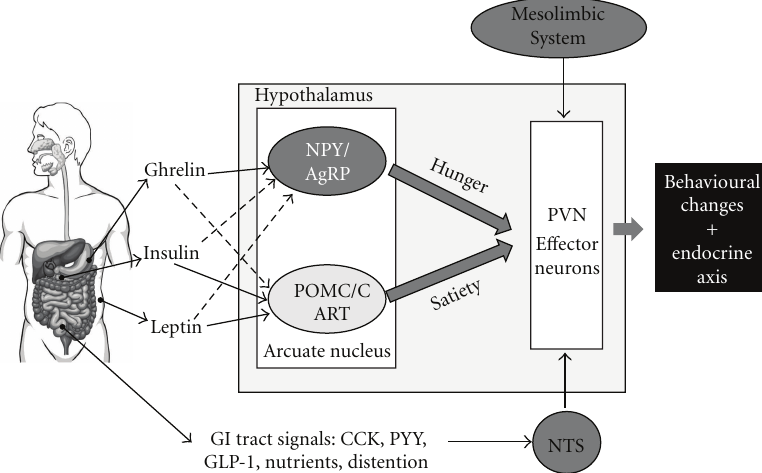
Figure 1: The Food Intake network is a complex system compromising several levels. See text for further information. CCK: cholecystoki- nine; GLP-1, Glucagon-like peptide 1, NTS, nucleus of the solitary tract, PVN, paraventricular nucleus; PYY, Peptide YY.